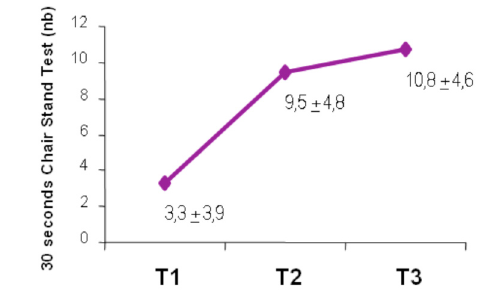
Figure 4. 30 Seconds Chair Stand Test